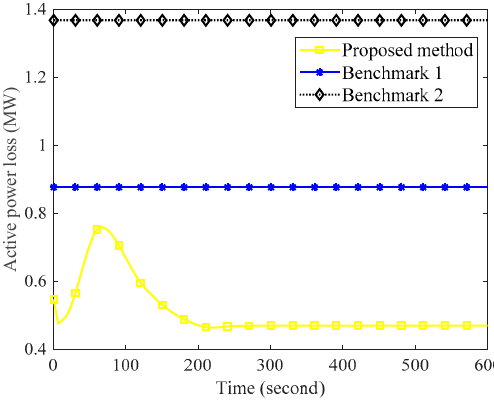
Figure 6. The lowest distribution bus voltage in the 33-bus systems.